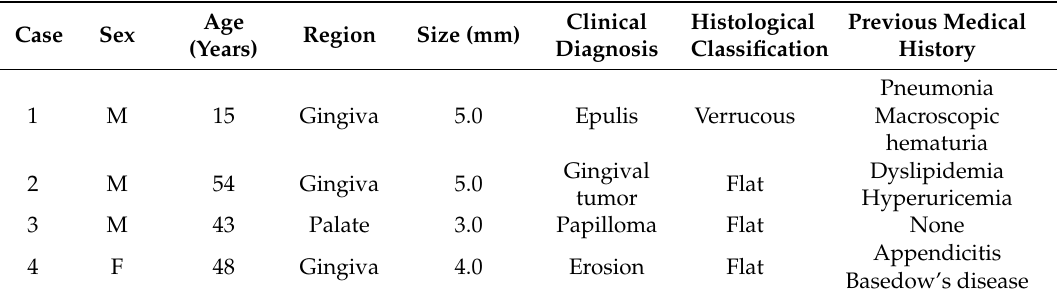
Table 1. Clinical and histological characteristics of patients with oral verruciform